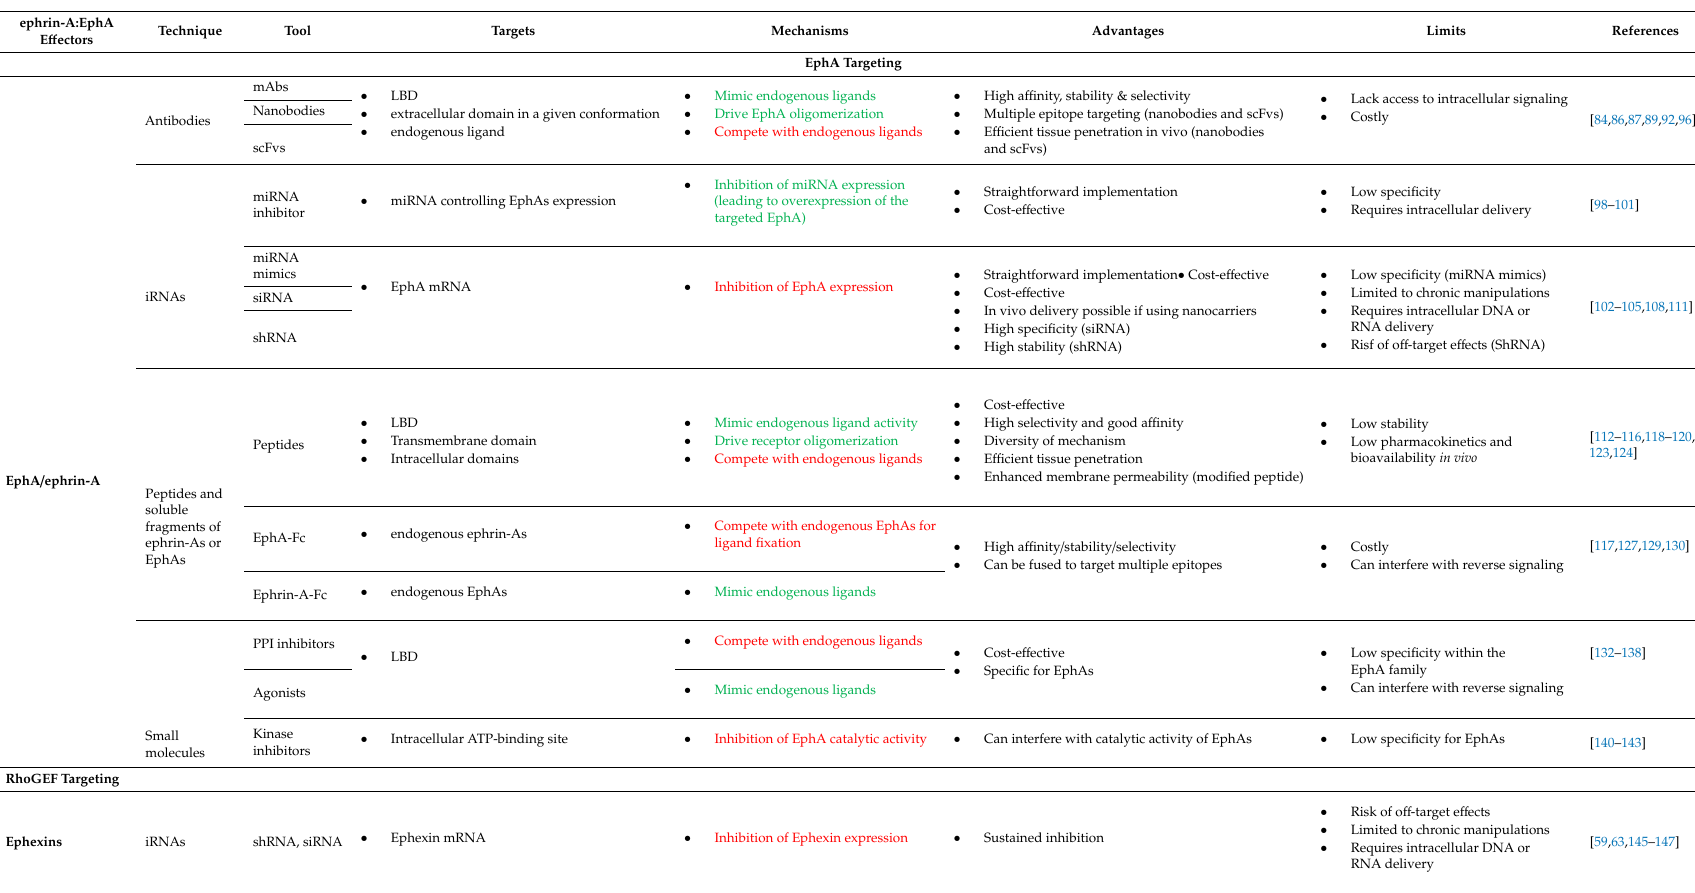
Table 1. Summary of available approaches to manipulate ephrin-A:EphA forward signaling. The mechanism of activating and inhibiting approaches is denoted in green and red